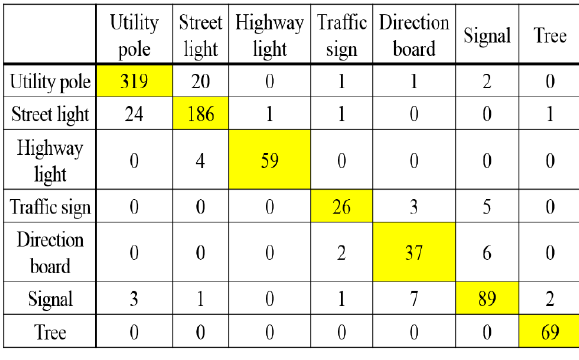
Table 3. Classification results